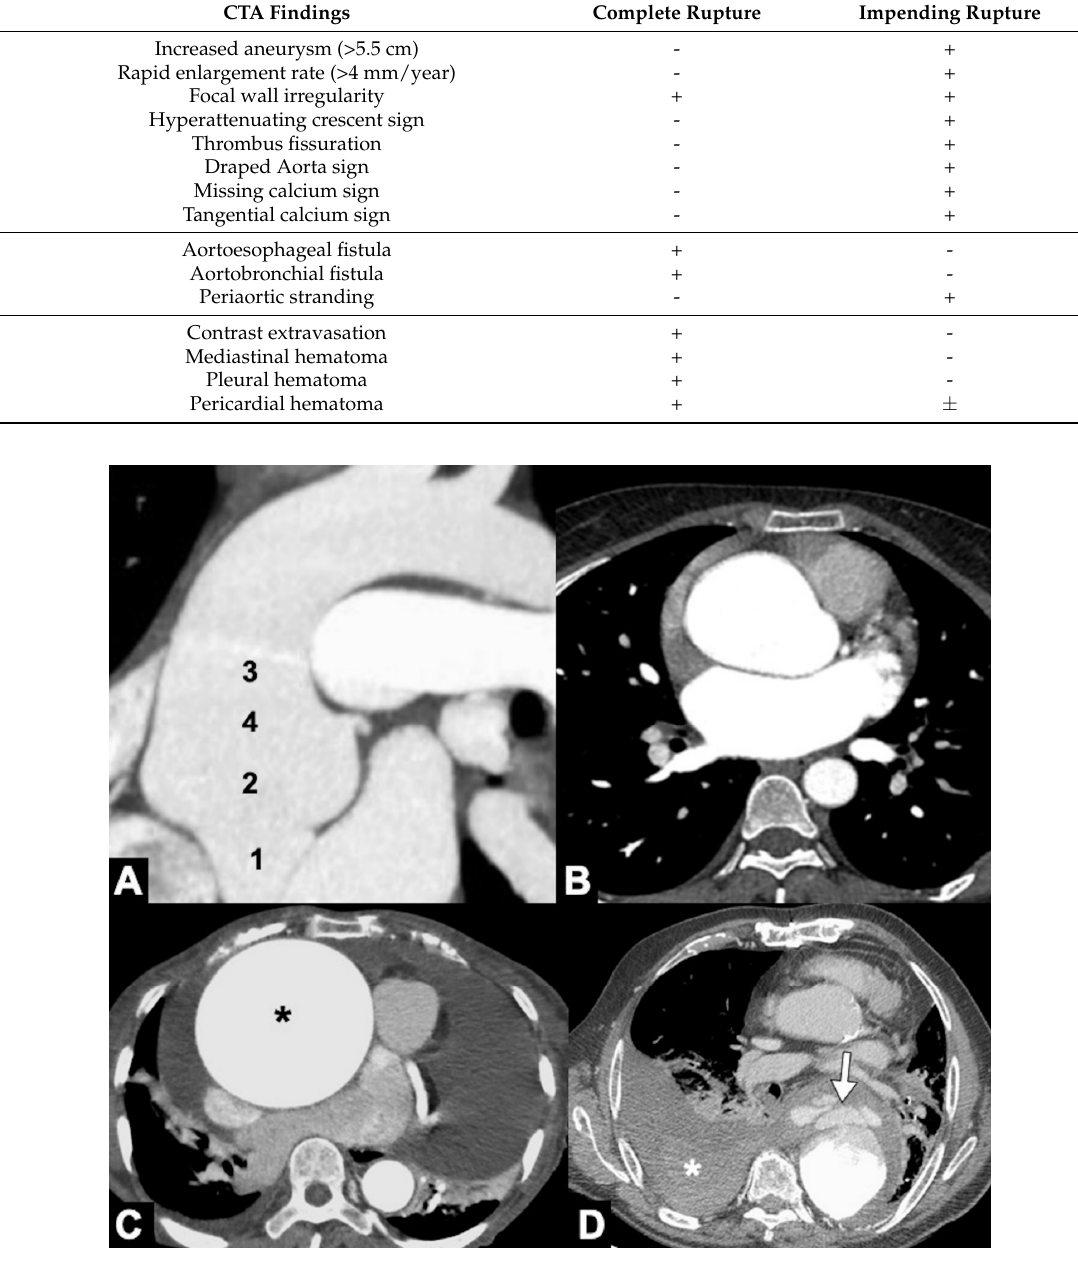
Figure 11. CTA of thoracic aorta aneurysms. ( A ) Marfan syndrome, a multisystem connective tissue disease caused by a defect in the protein fibrillin 1, and annuloaortic ectasia in a 42-year-old man. Sagittal MIP reconstruction image shows a proximal dilatation of the aortic anulus ( 1 ), sinuses of Valsalva ( 2 ) along with effacement of the STJ ( 4 ) producing a pear-shaped ascending aorta ( 3 ). ( B ) Axial CTA image shows sinuses ectasia in the same patient. In Marfan syndrome, a cut-off value of 5 cm of the ascending aorta diameter is recommended for surgical repair. ( C ) Axial CTA image shows a 12 cm ascending aorta aneurysm (asterisk) and a large mediastinal effusion. The risk of rupture of TAAs increases with size of the aneurysm according to Laplace’s law. ( D ) Axial CTA image shows a ruptured atherosclerotic aneurysm of the descending thoracic aorta. Note the high-attenuation fluid in the right pleural space, representing acute hemothorax (asterisk), and contrast medium extravasation from the aortic lumen (arrow).